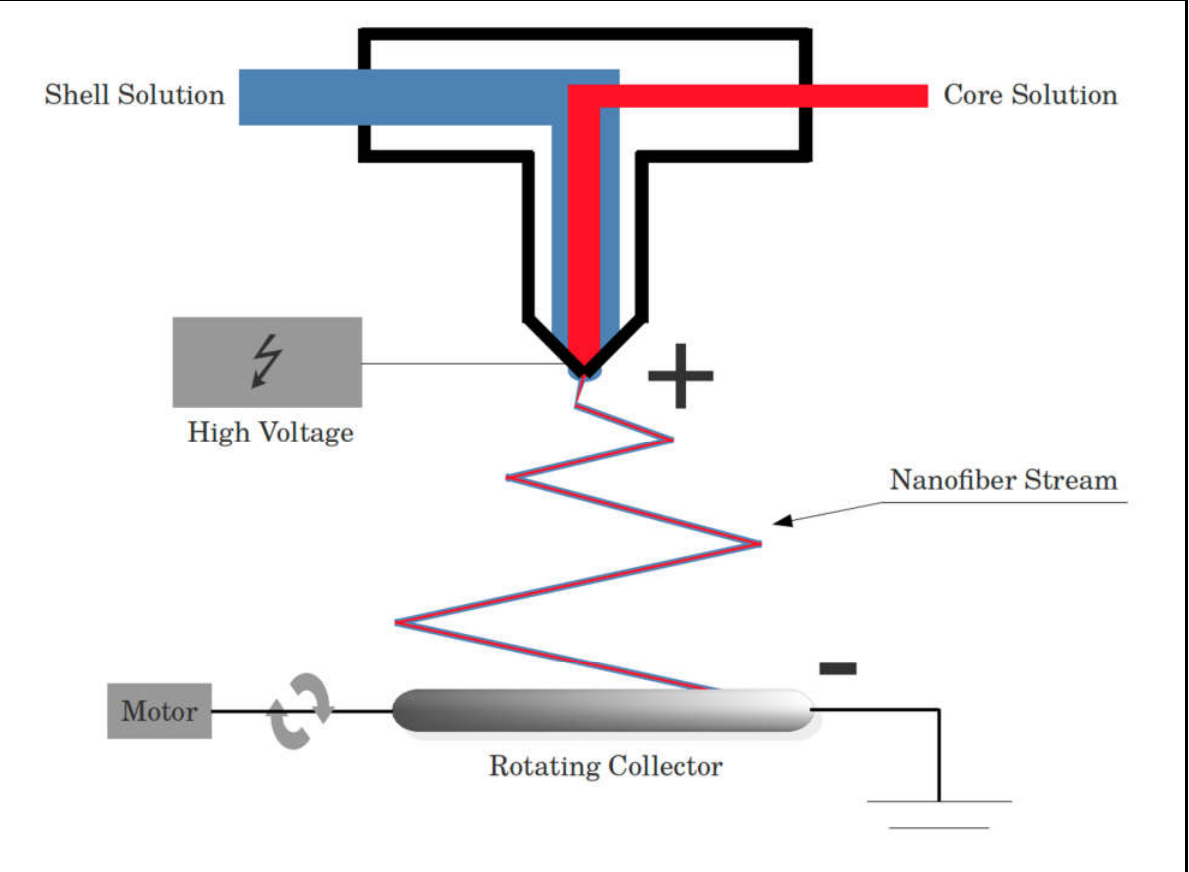
Figure 3. A scheme of coaxial electrospinning. Two separate syringes pump core (heparin) and shell solutions at different feeding rates to a rotating collector under working voltage. The needle tip to collector distance and collector rotating speeds can be adjusted.